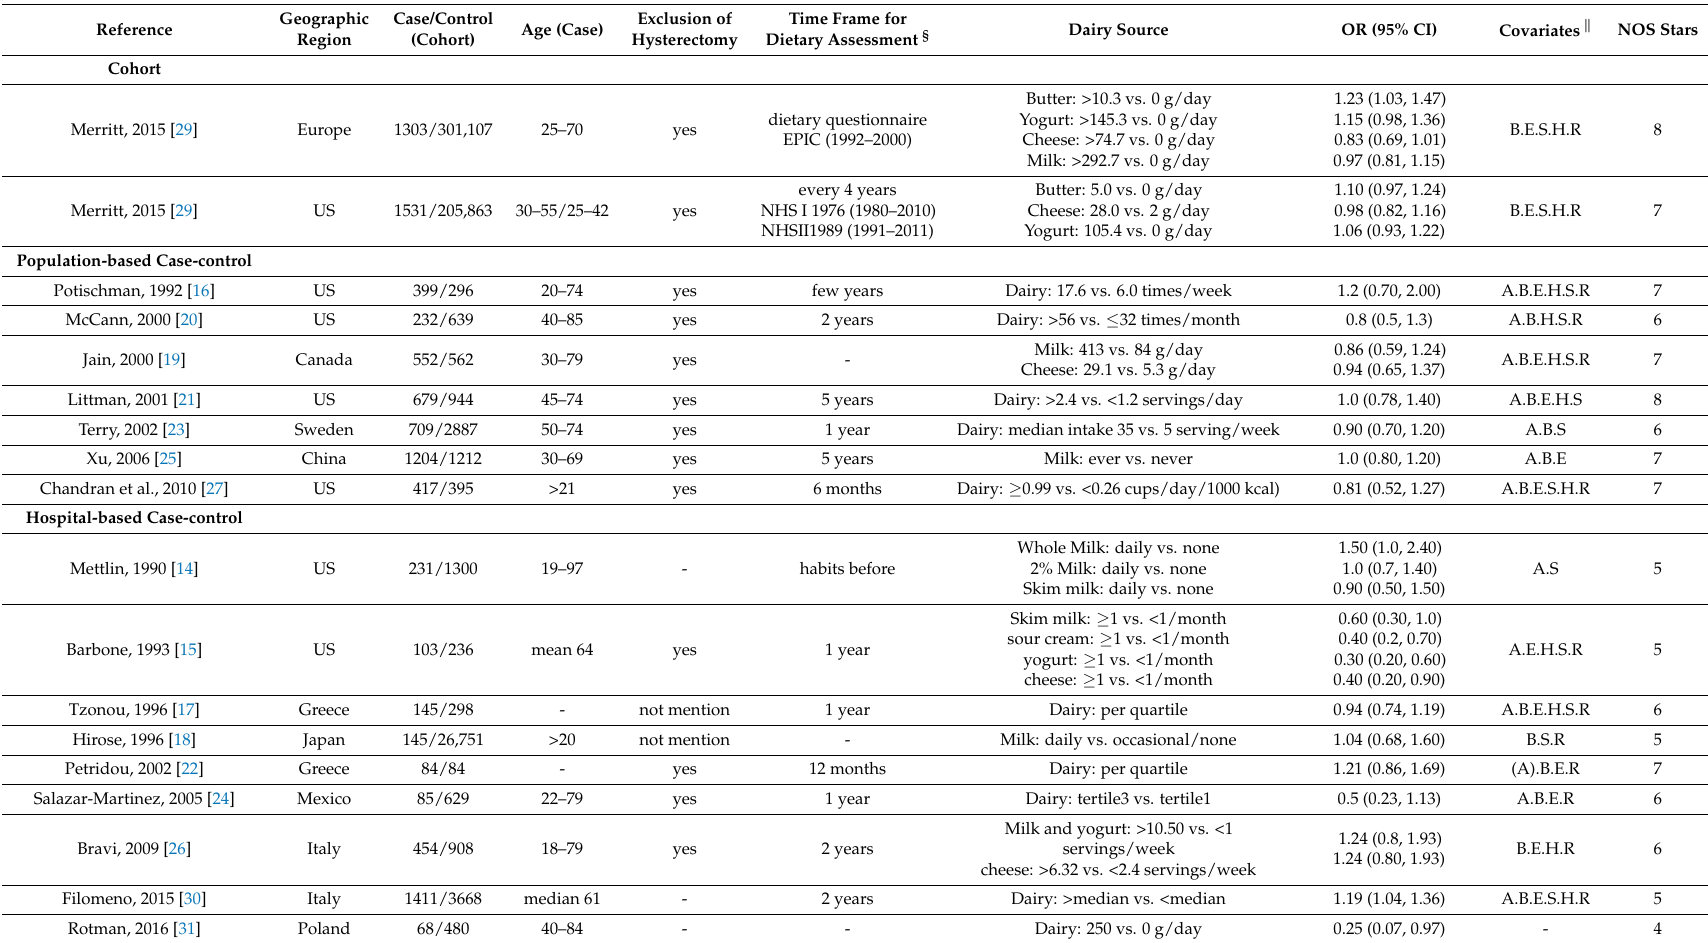
- Dairy: 250 vs. 0 g/day 0.25 (0.07, 0.97) - 4 § Time before onset of cancer or before interview; (cid:107) Covariates: A = age, B = body mass index (BMI) or weight, E = total energy, H = HRT (hormone replacement therapy) or estrogen use, R = reproductive factors, S = Smoking. (A): matched on age; NOS: Newcastle—Ottawa Scale; OR: odds